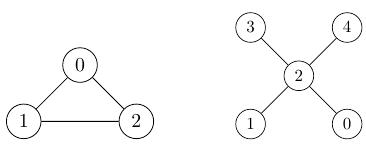
Figure 2 . A(cid:14)ne Dynkin diagrams for b A